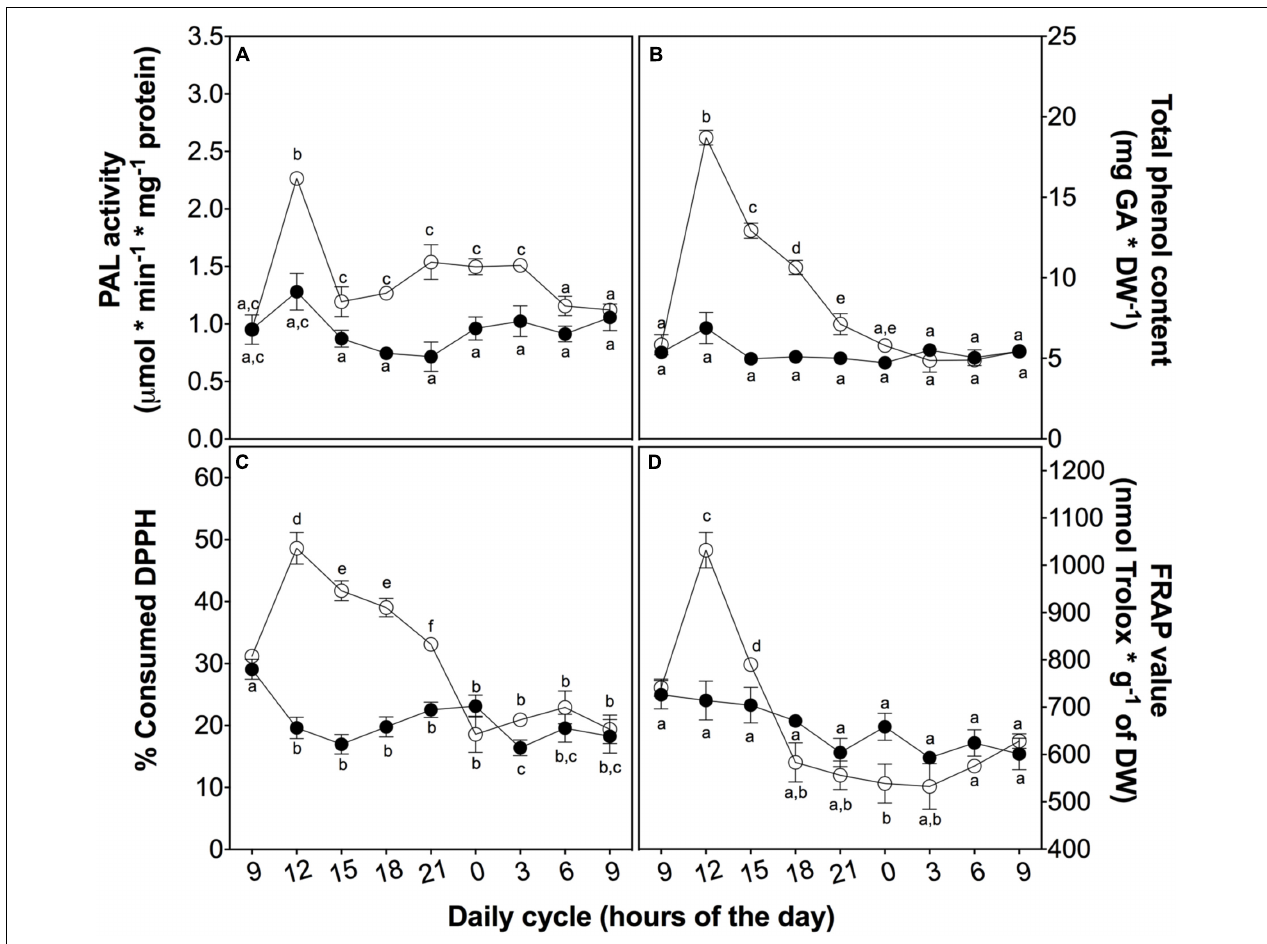
FIGURE 5 | Non-enzymatic antioxidant activity in D. antarctica plants exposed to UVB radiation and control conditions. PAL activity (A) The total phenolic content (B) , the consumption of DPPH radical (C) and reducing power of hydroalcoholic extracts (D) is observed. Open circles represent means ( ± standard error of the mean; N = 3) of plants that underwent the UVB treatment and closed circles represent the control means ( ± standard error of the mean; N = 3). Significant differences between treatments are indicated by letters ( ∗ P <